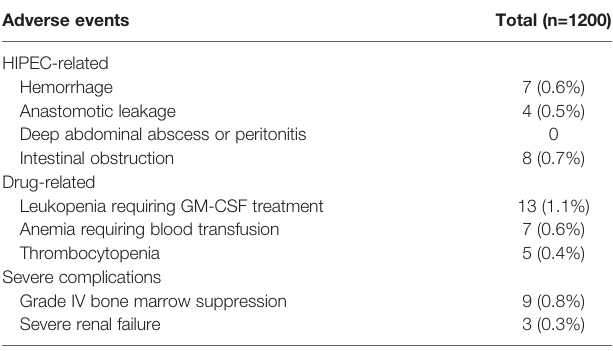
TABLE 3 | HIPEC- and drug-related adverse